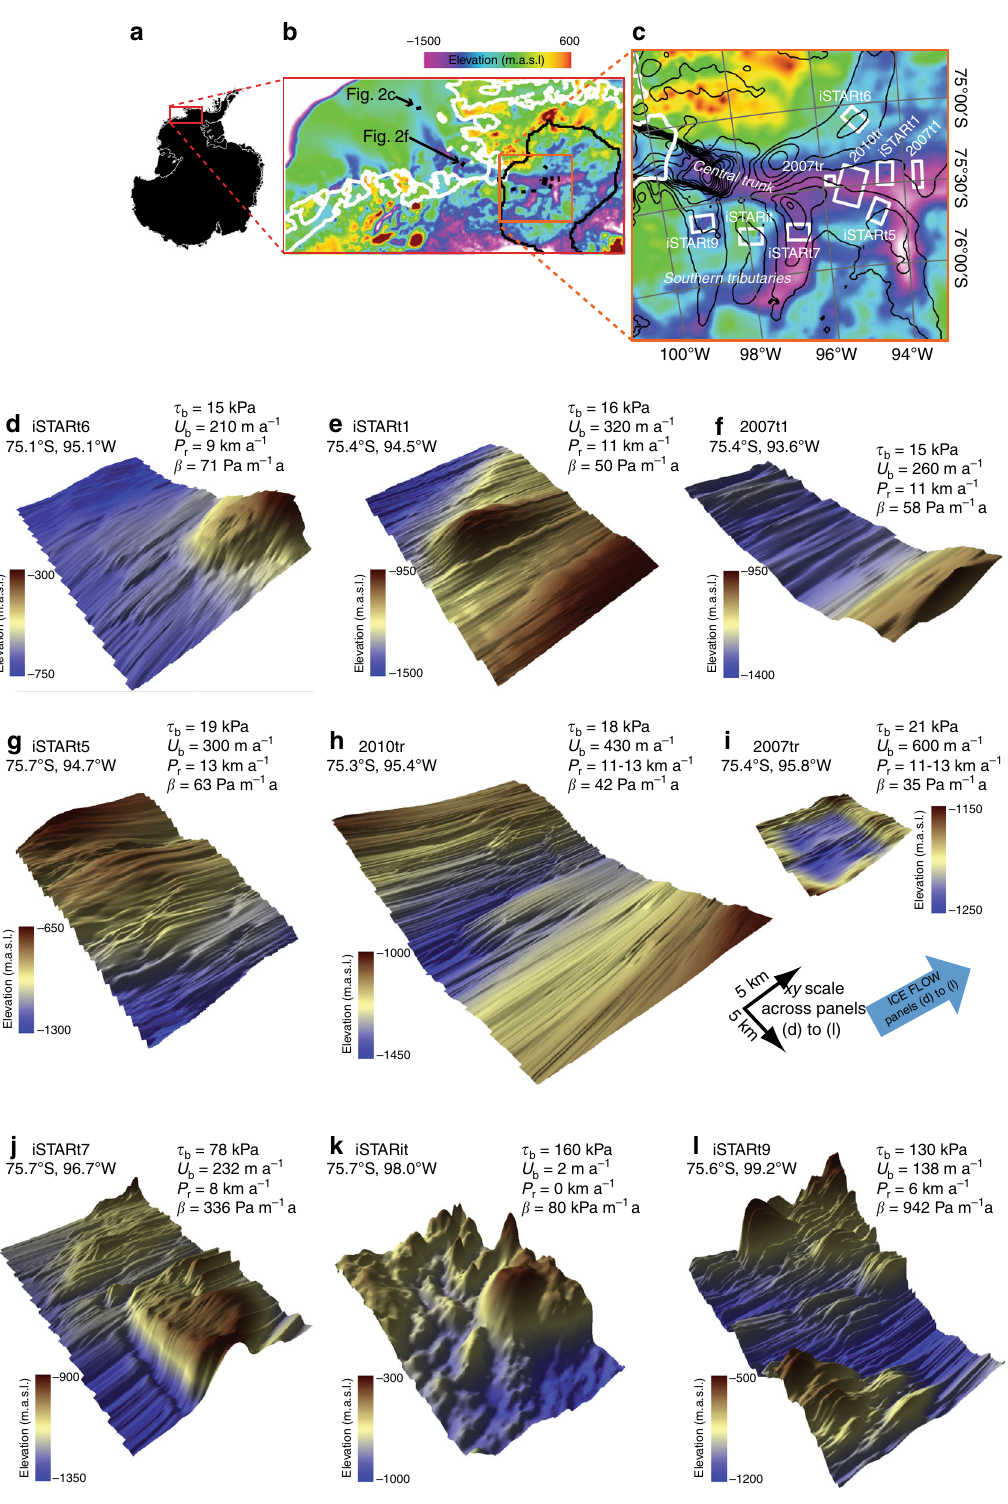
Fig. 1 High-resolution images of the bed across Pine Island Glacier. a Location and context. In b , the colourmap shows regional bed topography from Bedmap2 23 , the black line is the ice divide, the white line is the grounding line 51 , and high-resolution survey patches are shown as black rectangles. Locations of offshore bathymetry shown in Fig. 2c, f are marked. c uses the same schema but demarcating survey patches with white rectangles, labelled by season of data acquisition (2007/08, 2010/11 and ‘ iSTAR ’ = 2013/14) and an end label denoting the location (where ‘ tr ’ = trunk; ‘ it ’ = intertributary and ‘ t1, t5 …’ denotes tributaries numbered after ref. 52 . Surface ice velocities 53 contoured at 100-m intervals are also shown. d – l Perspective views of the bed beneath Pine Island Glacier, together with parameters of ice fl ow. Vertical exaggeration in all images = 10. τ b and U b are the mean basal shear stress (kPa) and mean basal ice velocity (m a − 1 ) from model inversion 37 ; P r is the measured upstream propagation rate of ice thinning per ice-stream tributary from 1992 to 2015 using a thinning/non-thinning threshold of 1.0 m a − 1 6 and β is the inverted basal traction coef fi cient equal to τ b / U